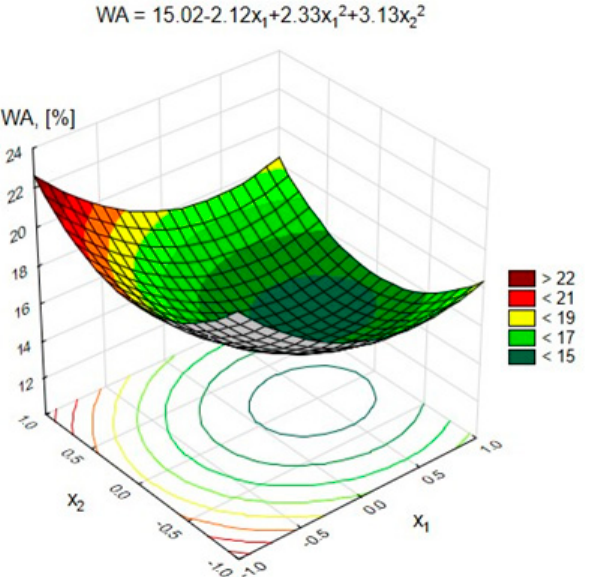
Figure 8. Changes in the water absorption of GLC depending on x 1 and x 2 at x 3 = 0 (10 M).